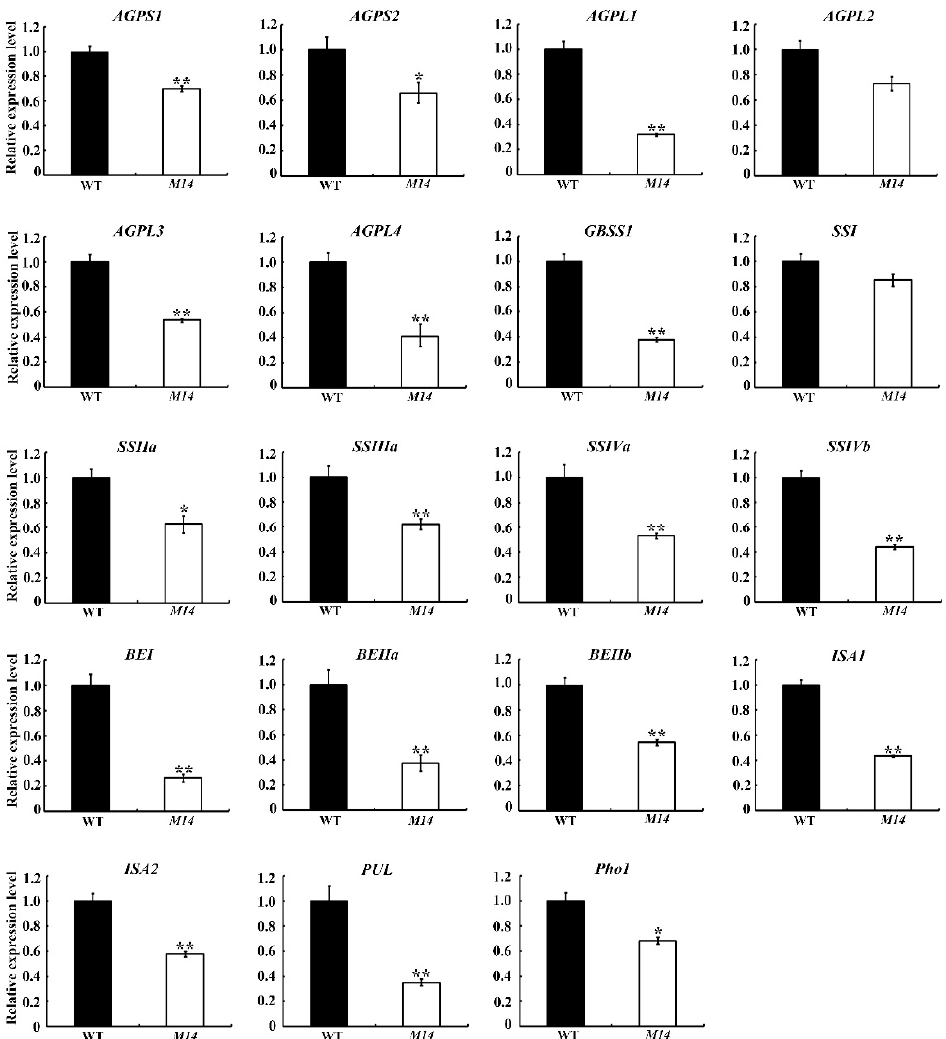
Figure 7. Expression of starch biosynthesis-related genes in WT and M14 . Total RNA extracted from 9 DAF endosperm is used for qRT-PCR analysis. ADP glucose pyrophosphorylase small subunit (AGPS1 and AGPS2) and large subunit (AGPL1, AGPL2, AGPL3, and AGPL4); granule-bound starch synthase I (GBSSI); soluble starch synthase I, IIa, IIIa, IVa, and IVb (SSI, SSIIa, SSIIIa, SSIVa, and SSIVb); branching enzyme I, IIa, and IIb (BEI, BEIIa, and BEIIb); isoamylase isozymes (ISA1 and ISA2); pullulanase (PUL); plastidial phosphorylase (Pho1). The expression level of every target gene in WT is set at 1.0. All data are given as means ± SD ( n = 3). ** and * indicate significant differences between WT and M14 at p < 0.01 and p < 0.05 by Student’s t test.